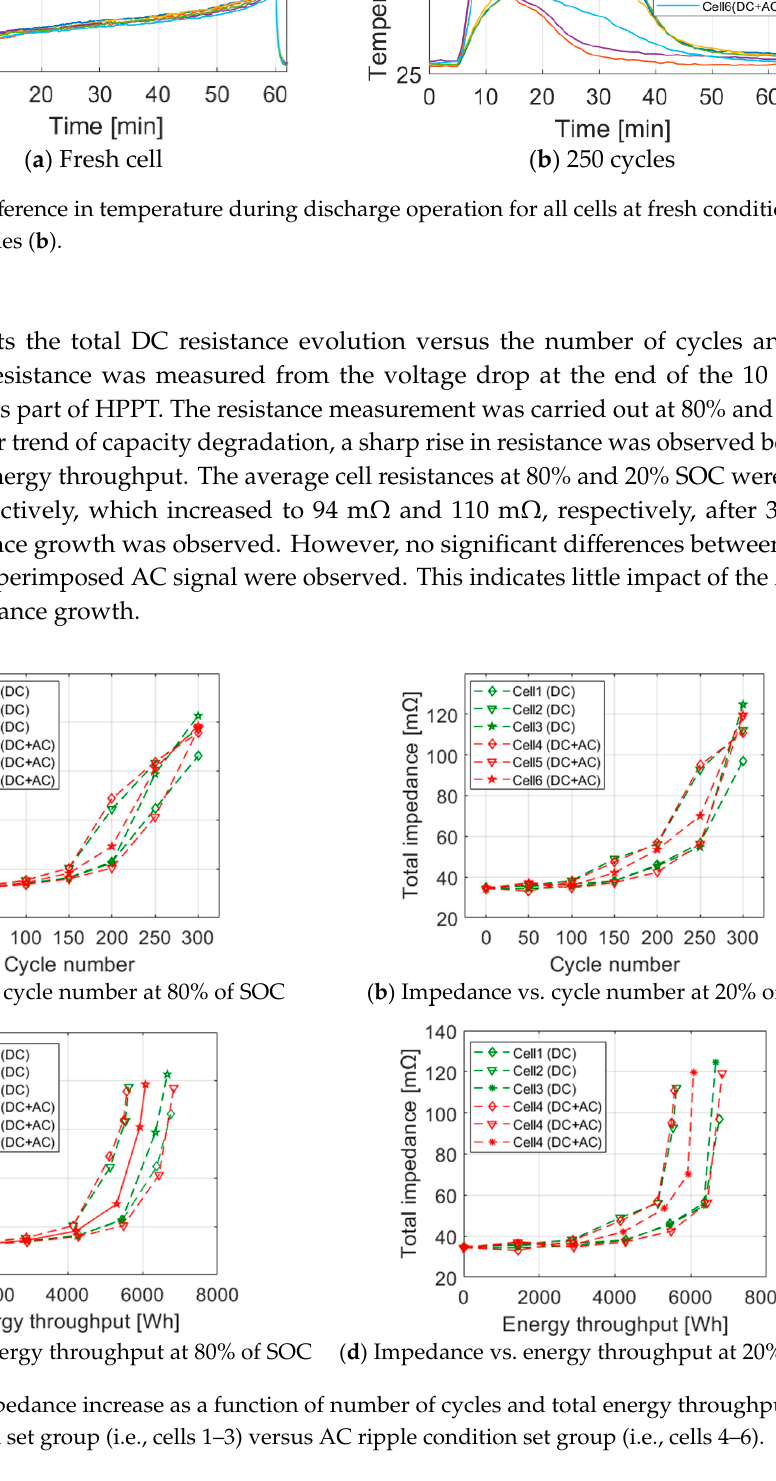
Figure 8. DC impedance increase as a function of number of cycles and total energy throughput for normal condition set group (i.e., cells 1–3) versus AC ripple condition set group (i.e., cells 4–6).